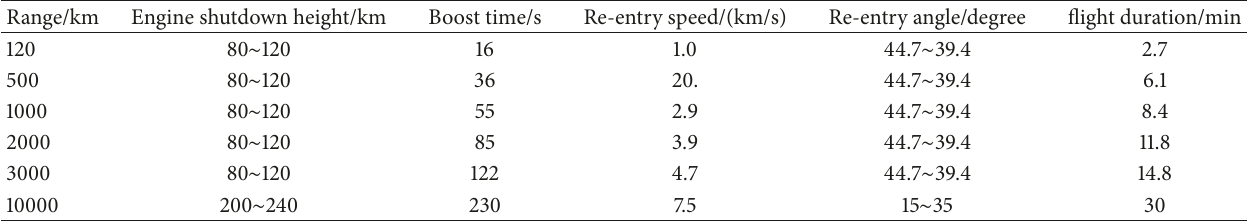
Table 1: Target characteristics of typical submarine-launched ballistic missiles